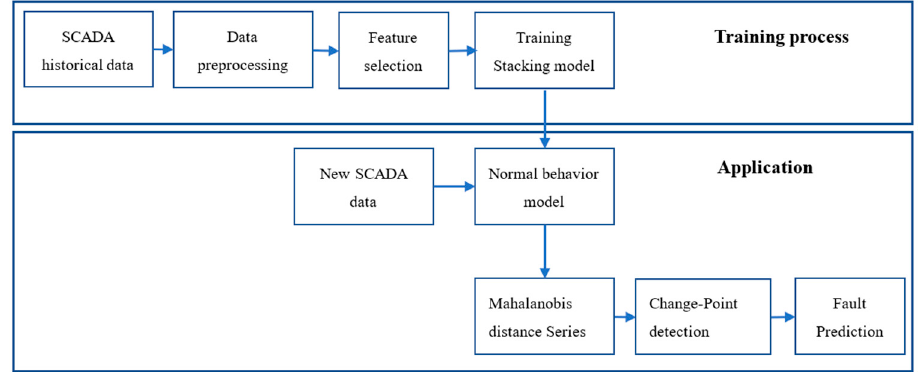
Figure 2. Overview of the overall framework.